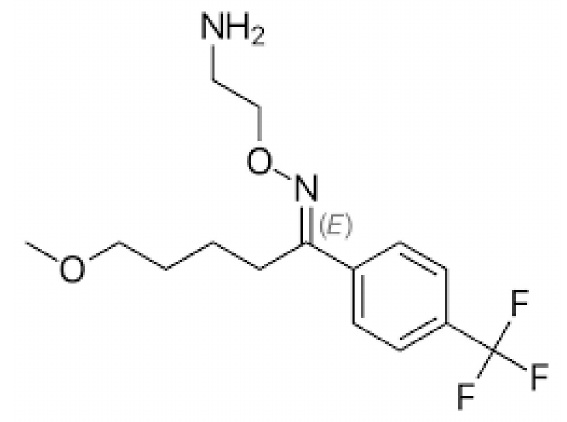
Figure 18. Structure of